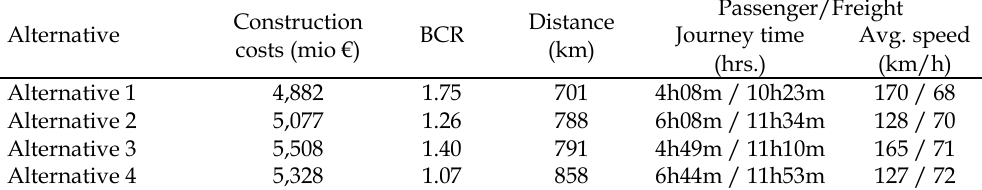
Four alternatives, costs (2010 price level), distance, journey time and average